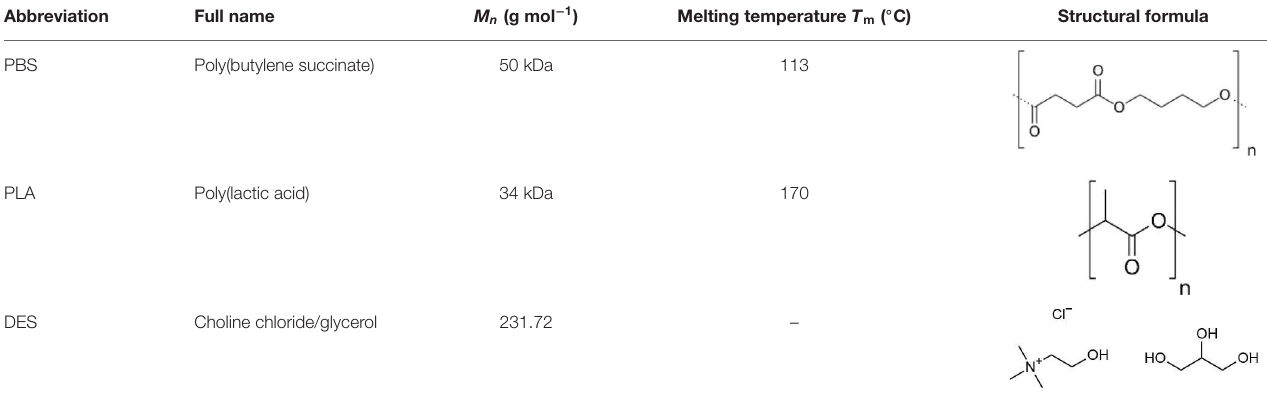
TABLE 1 | Formula of studied polymers and deep eutectic